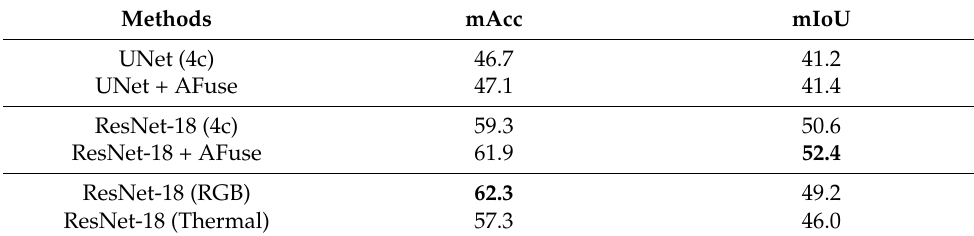
Table 3. The effectiveness of ResNet-18 as the backbone of encoder